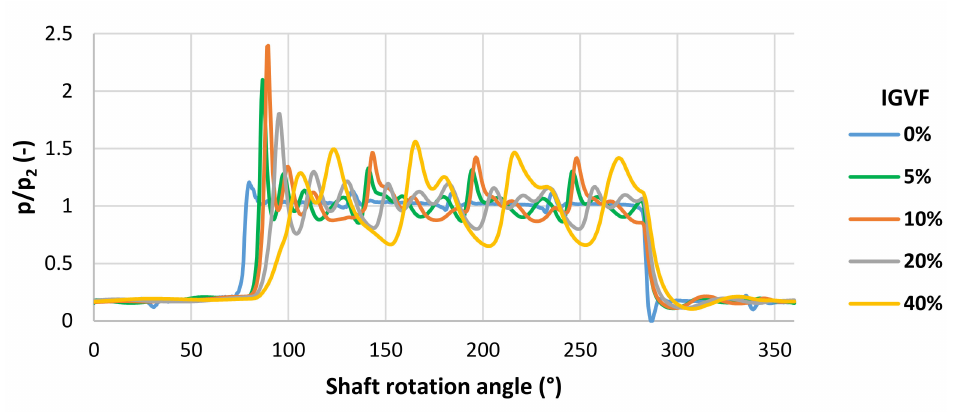
Figure 27. Displacement chamber pressure profiles for the TMC pump obtained from the CFD simulations at p 2 = 5 bar pressure load, 20 ◦ C oil temperature, 2000 rpm and different